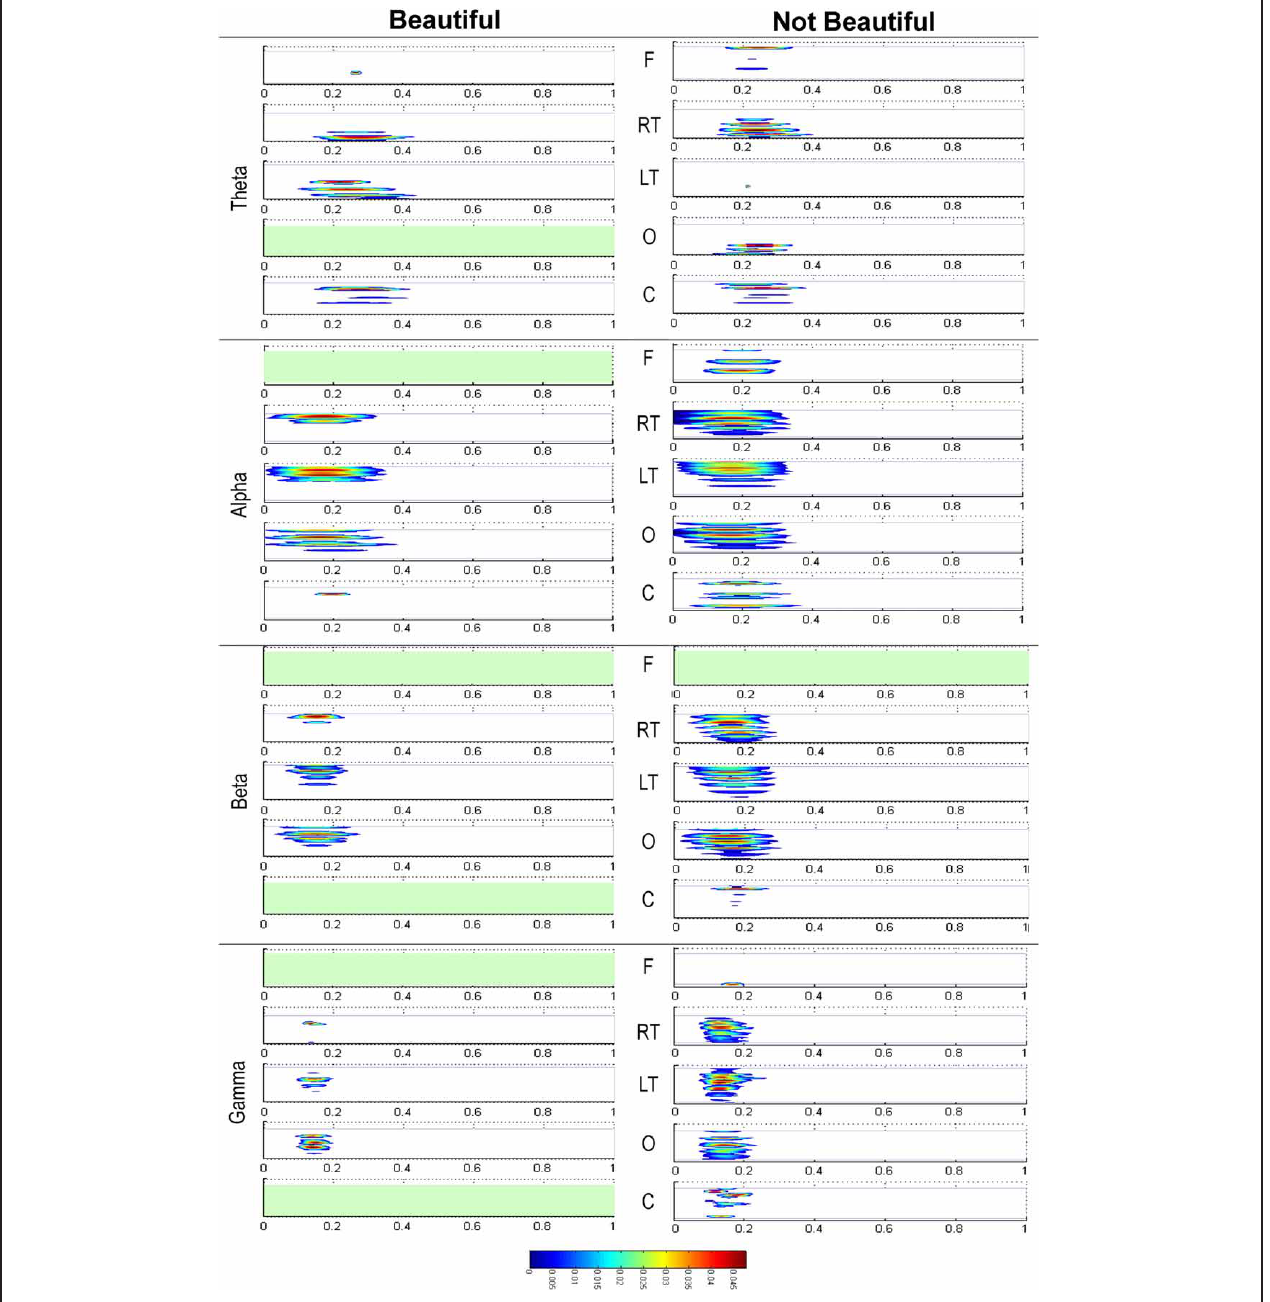
FIGURE 4 | Representation of the time-frequency baseline corrected changes for stimuli rated as “beautiful” and “not beautiful” resulting from the Kruskal Wallis tests ( p < 0 . 001) with FDR correction. They are